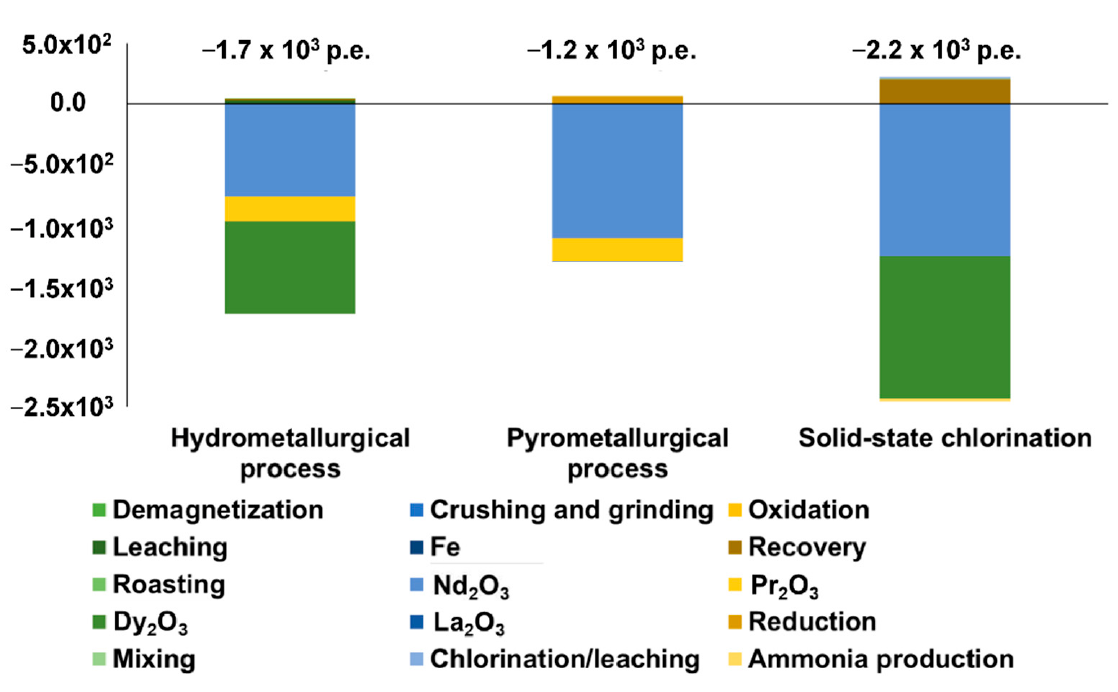
Figure 5. Normalisation and weighing results of the three treatments: effect of the different step expressed as p.e. (functional unit: 1000 kg of Nd-Fe-B permanent magnets).